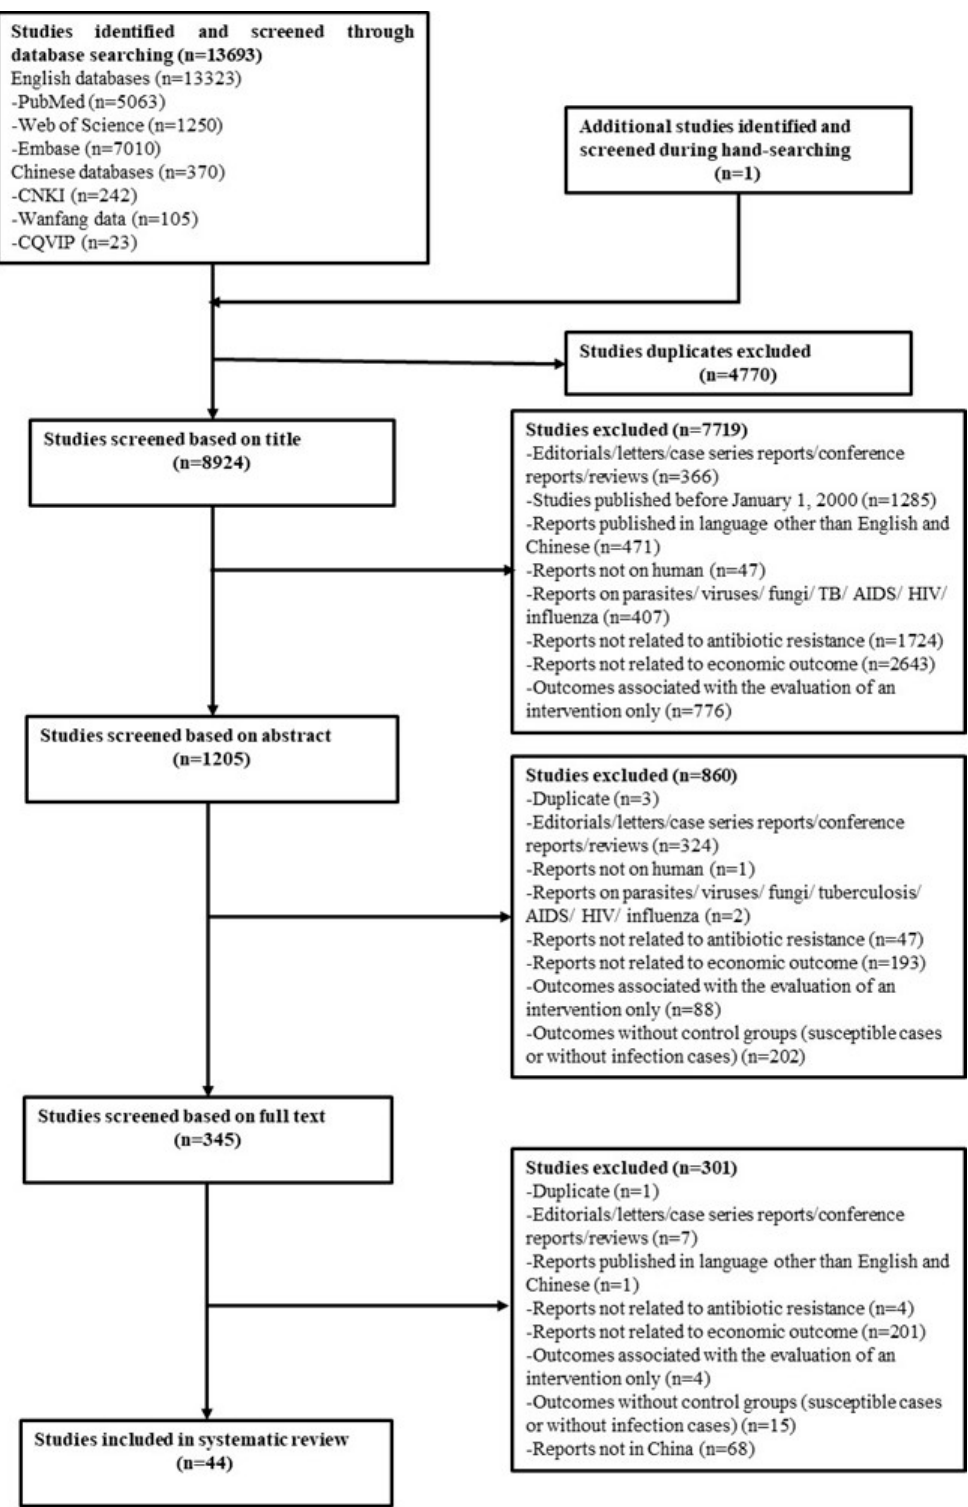
Figure 1. Flowchart of literature search. CNKI: China National Knowledge Infrastructure; CQVIP: Chongqing VIP; TB: Tuberculosis; AIDS: acquired immunodeficiency syndrome; HIV: human immunodeficiency virus.